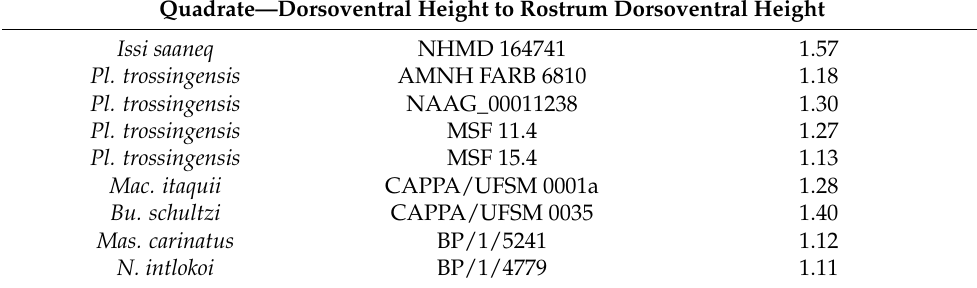
Figure 19. Digital reconstruction of the left quadrate of NHMD 164758. ( A ) Lateral view. ( B ) Medial view. ( C ) Anterior view. ( D ) Posterior view. Abbreviations: lc, lateral condyle; mc, medial condyle; mf, medial flange; ptas, articular surface for the pterygoid. Scale bar = 20 mm. Table 4. Quadrate dorsoventral height to rostrum dorsoventral height ratio. The rostrum height is measured at the posterior margin of the external naris, from the ventral tip of the maxilla to the dorsal tip of the nasal. Measurements were taken on the 3D models when